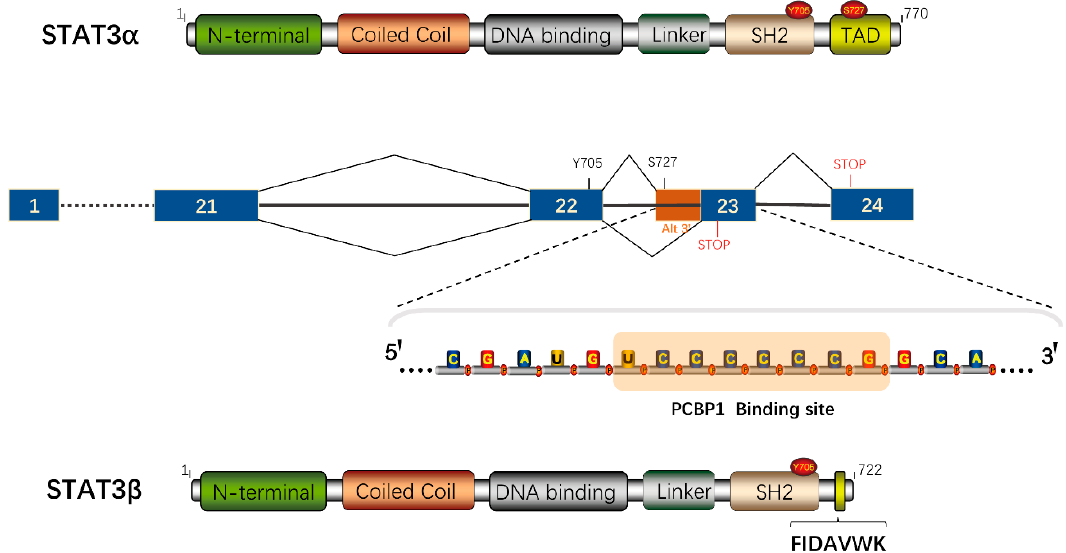
Figure 1. Schematic diagram of the structure and the alternative splicing pattern of STAT3. PCBP1 binds to “UCCCCCCG” and promotes the usage of an alternative 3’ splicing site in exon 23, which increases the expression of STAT3 β . The TAD (transcriptional activation domain) of STAT3 α is replaced by FIDAVWK.